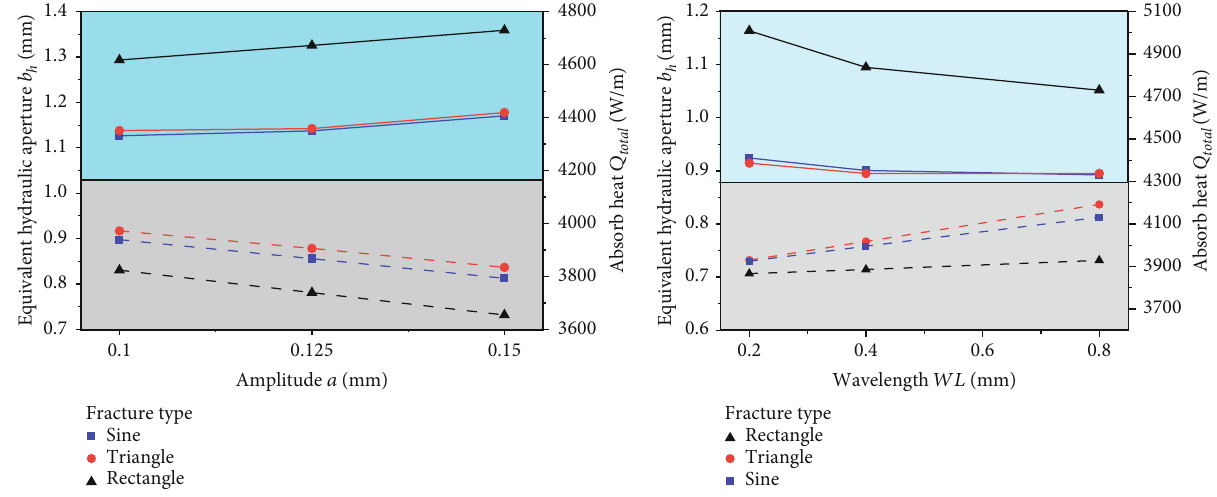
Figure 13: In fl uence of topographic features on fl uid fl ow and heat transfer in